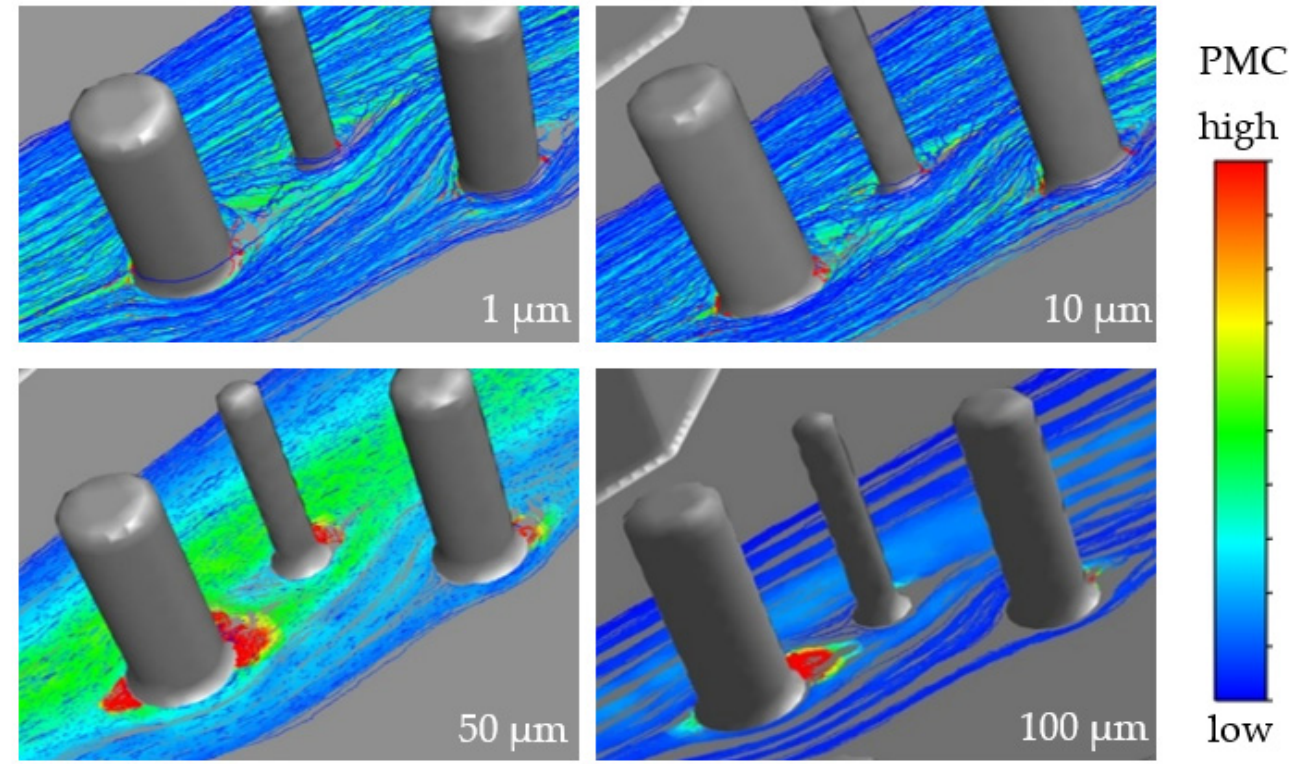
Figure 7. Flow-around and deposition of particles as a function of particle diameter.